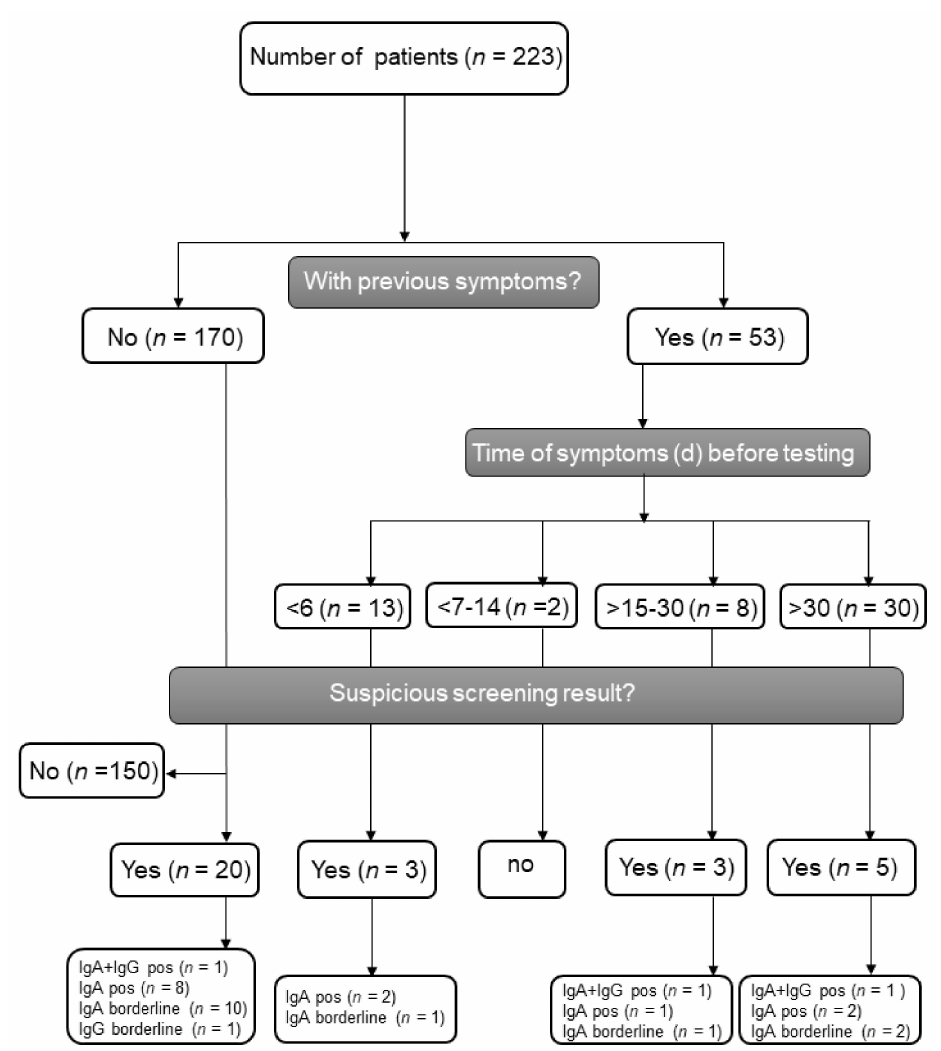
Figure 1. Flow scheme of SARS-CoV-2 antibody screening and test results divided by previous symptoms. IgA = Immunoglobulin A, IgG = Immunoglobulin G, pos =